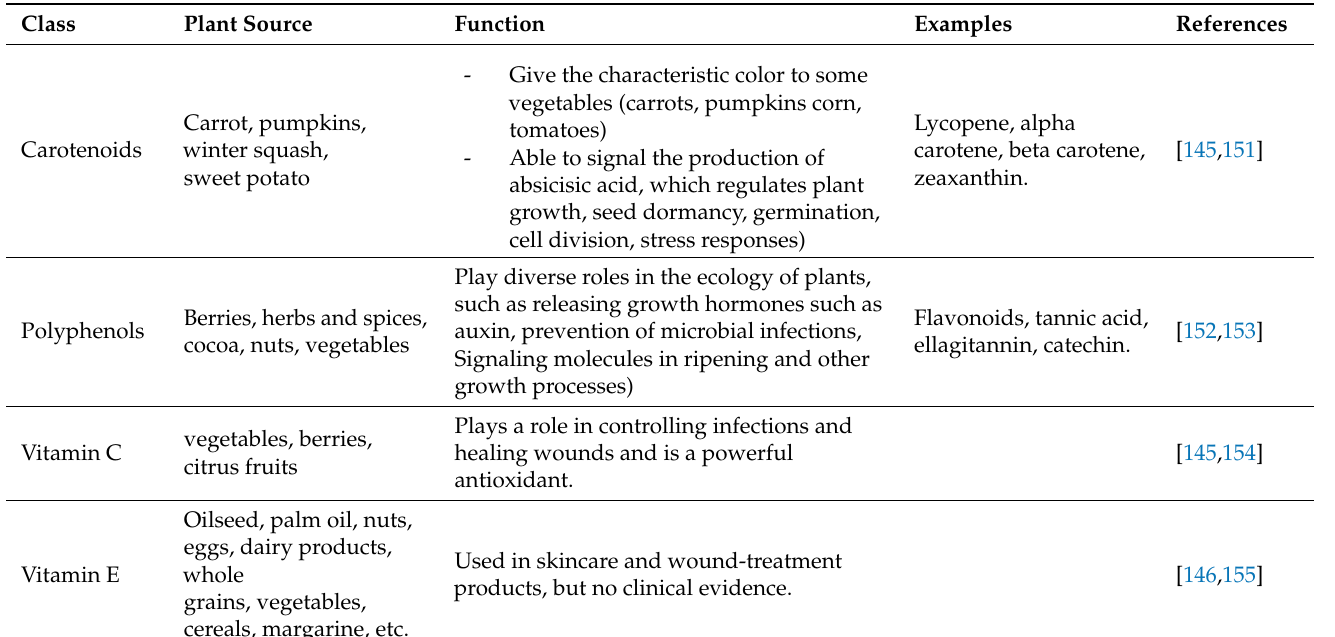
Table 4. Most common antioxidant-based plant